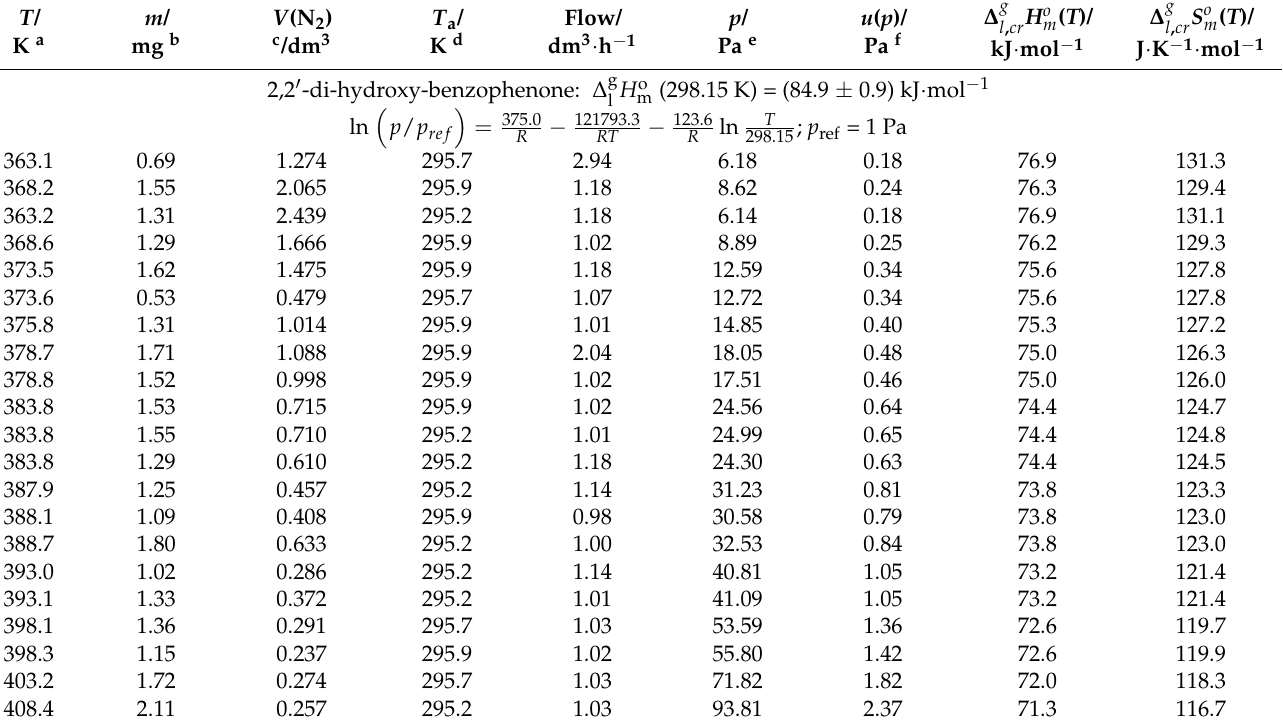
Table 1. Results of transpiration method for substituted benzophenones: absolute vapour pressures p